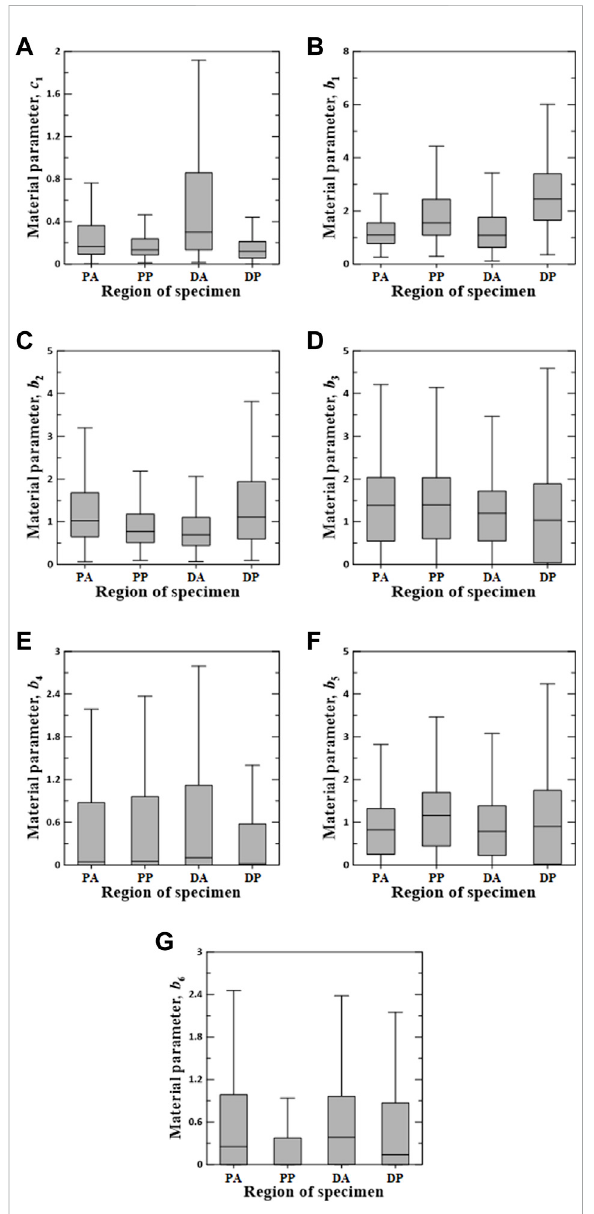
FIGURE 6 Random value distribution of material parameters estimated using Fung model for PA, PP, DA, and DP specimens. (A) c 1 , (B) b 1 , (C) b 2 , (D) b 3 , (E) b 4 , (F) b 5 , and (G) b 6 .